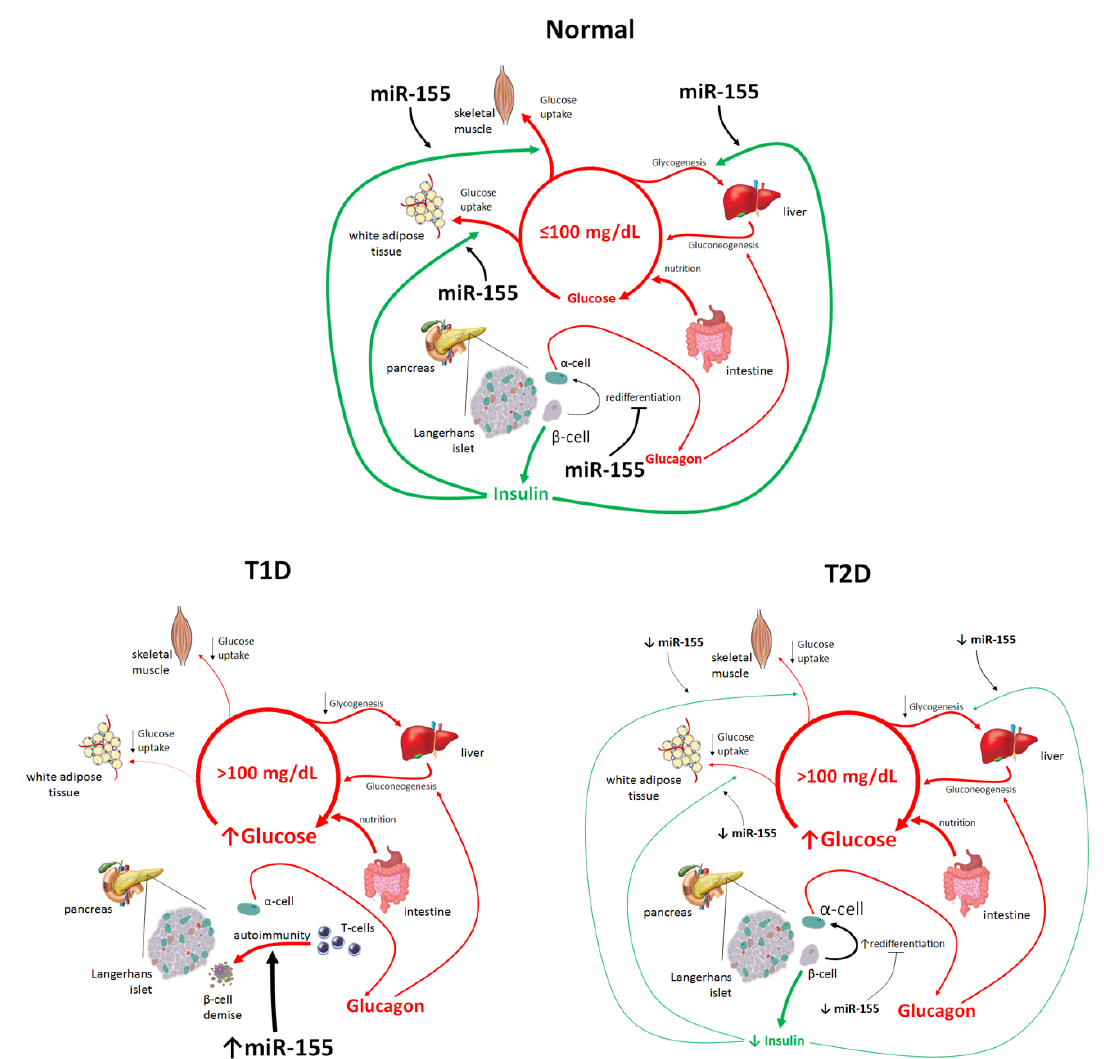
Figure 2. Functional roles of miR-155 in glucose homeostasis. The cartoon emphasizes the involvement of miR-155 in the key mechanisms underlying glucose homeostasis: in normal conditions, in type 1 diabetes (T1D) and in type 2 diabetes (T2D); miR-155 improves insulin sensitivity and glucose uptake in white adipose tissue and skeletal muscle and promotes gluconeogenesis in the liver. Moreover, miR-155 prevents the trans-differentiation of β -cells into α -cells under metabolic stress.